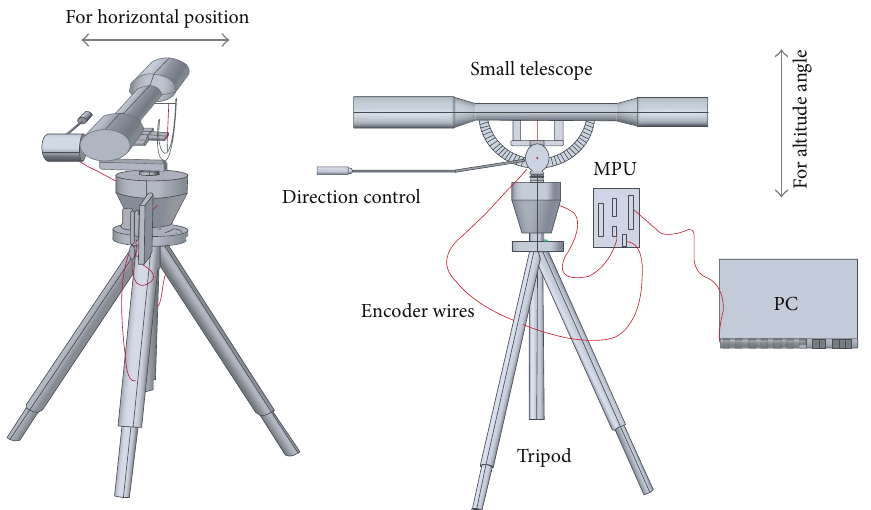
Figure 8: Introduction model of the proposed shading analyzer and site